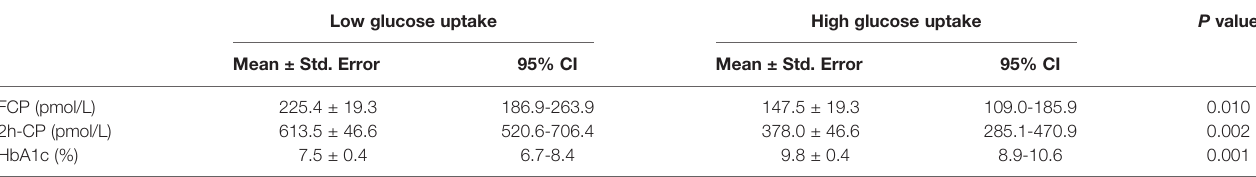
TABLE 4 | Clinical characteristics in T1D after adjustment for disease course.